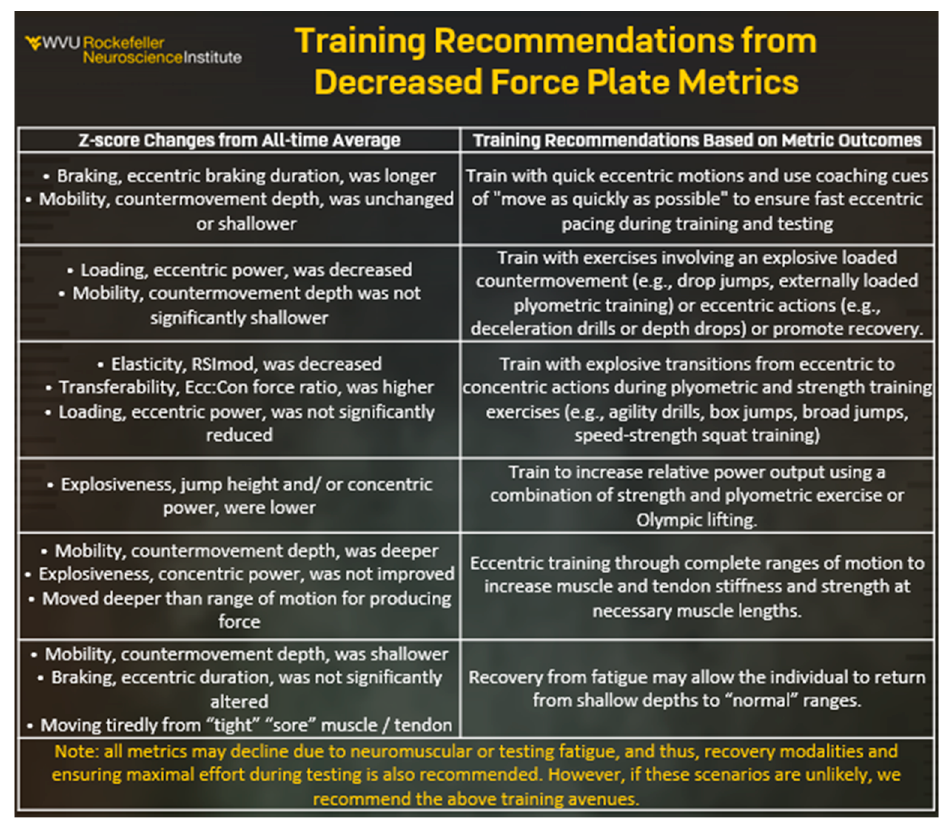
Figure 7. Example training recommendations based on decreased performances from countermovement jump force-time metrics. Note, these are general recommendations that may overlap across variables and still require the expertise of the strength and conditioning specialist to align these responses to the context of any scenario.